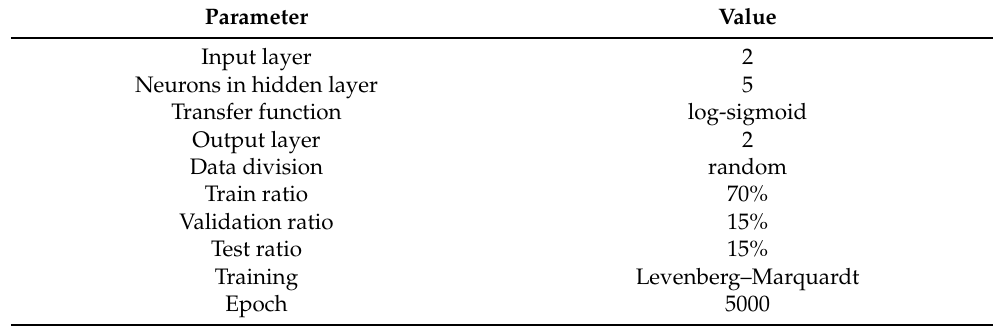
Table 1. FFNN configuration